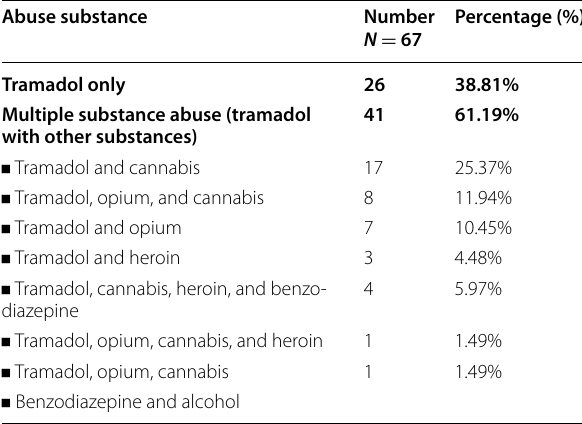
Table 4 Distribution of abused substance/substances among